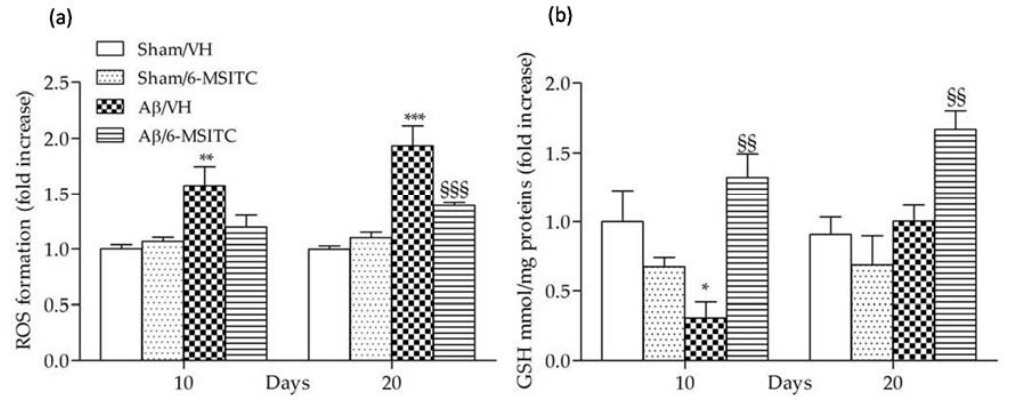
Figure 6. Effects of 6 ‐ MSITC (5 mg/kg) on cellular redox status after A β 1 ‐ 42 O injection. Redox status was determined in hippocampal samples 10 and 20 days after A β 1 ‐ 42 O injection ( a ) based on fluorescence emission of 2 ′ ,7 ′‐ dichlorofluorescein (DCF) at 535 nm after excitation at 485 nm. Values are expressed as mean of fold increase ± SEM ( n = 10) of fluorescence intensity arbitrary units (UF) of each experimental group compared to the Sham/VH group. GSH content was measured using a colorimetric assay in hippocampal samples 10 and 20 days after A β 1 ‐ 42 O injection ( b ). Values are calculated using a standard calibration curve and expressed as mean of fold increase ± SEM ( n = 10) of mmol GSH/mg proteins compared to the Sham/VH group. ( a : ** p < 0.01 and *** p < 0.001 vs. sham groups, §§§ p < 0.001 vs. A β /VH group; b : * p < 0.05 vs. Sham/VH, §§ p < 0.01 vs. A β /VH groups; ANOVA, post hoc test Bonferroni).